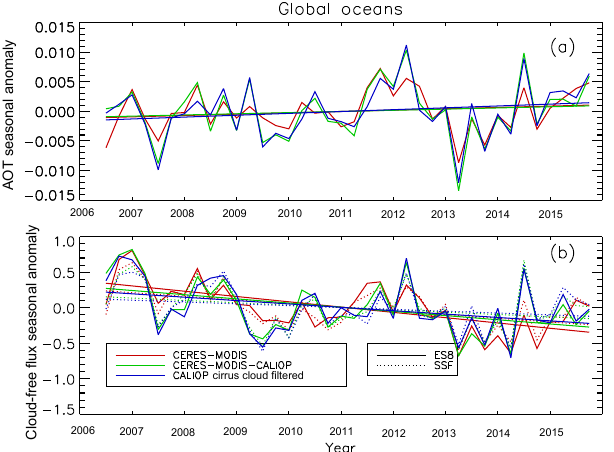
Figure 13. Global AOT trends derived from the (red) MODIS– CERES dataset, (green) MODIS–CERES–CALIOP dataset and (blue) MODIS–CERES–CALIOP dataset after filtering for cirrus clouds. Both CERES SSF and ES-8 data are included. Time se- ries have been derived utilizing seasonal AOT averages. CALIOP is used to locate and remove CERES observations contaminated with cirrus clouds. (b) Depicts the same thing as (a) , except for the cloud- free flux. This analysis is carried out for the Aqua-based study